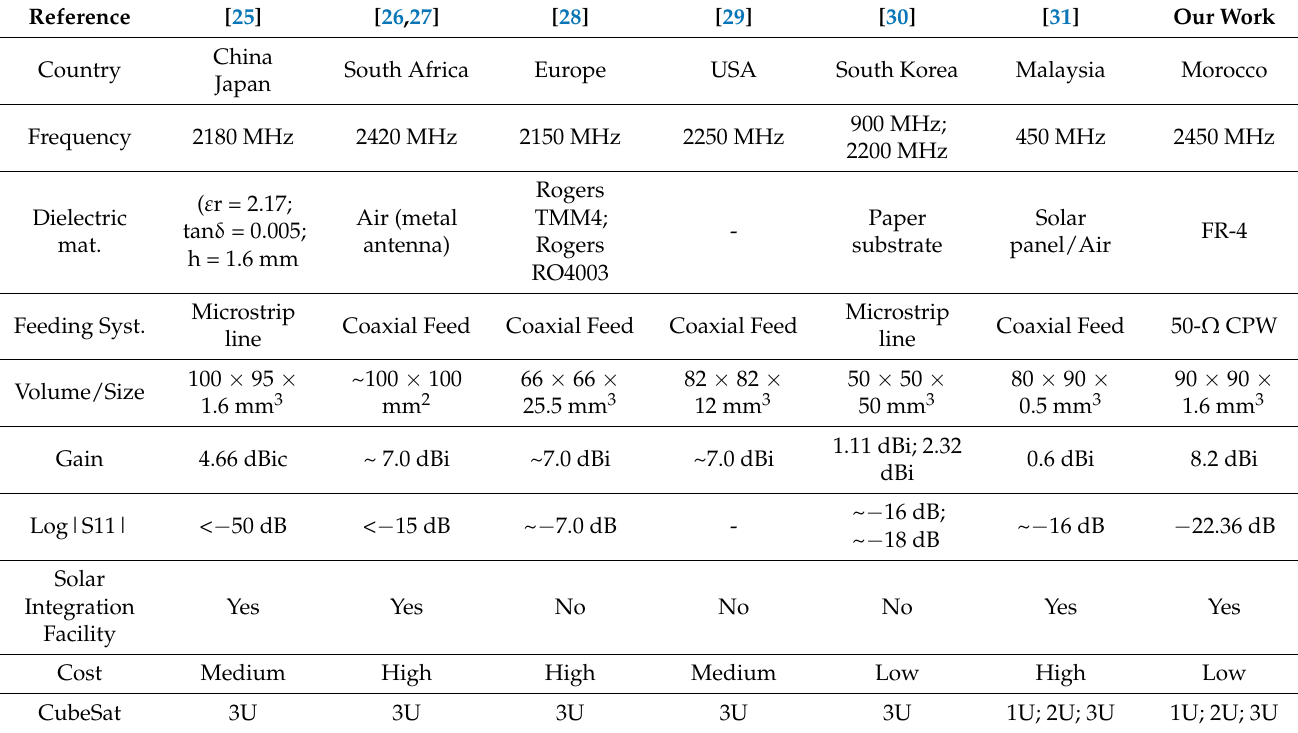
Table 8. Brief comparison with UHF- and S-bands planar antenna designs proposed by CubeSat